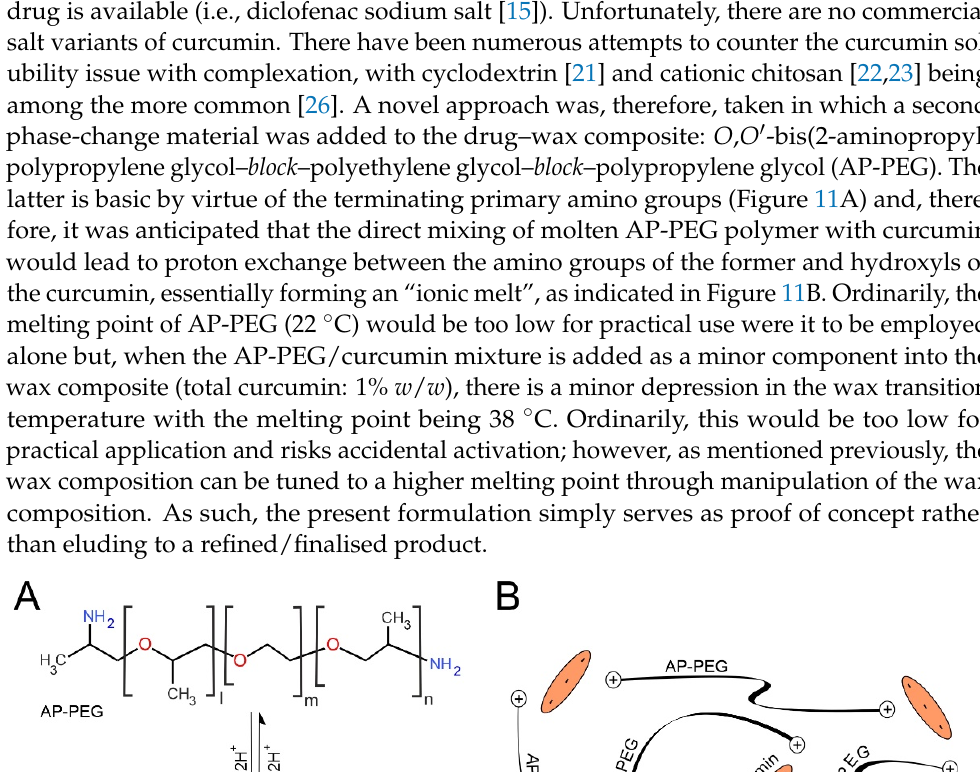
Figure 12B (based on λ max = 424 nm, ε = 25468 L − 1 · mol · cm − 1